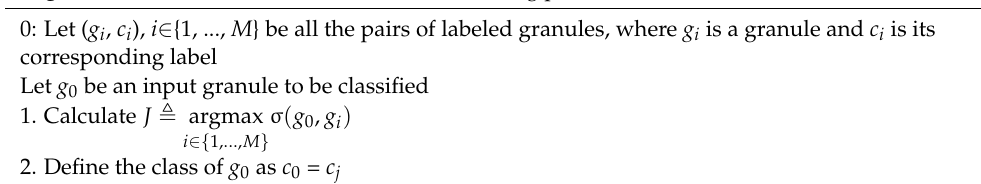
Algorithm 2. GbC: Granule-based-Classifier (testing